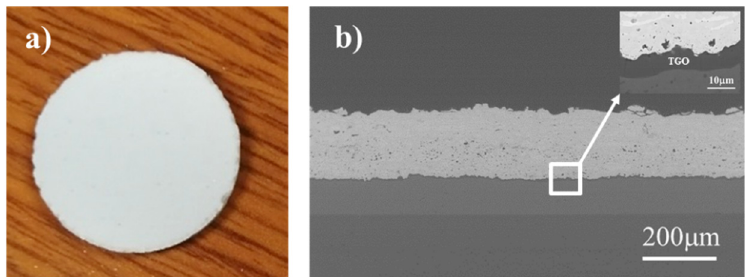
Figure 6. Photograph ( a ) and SEM image ( b ) of failed APS EBC after 600 steam cycling.